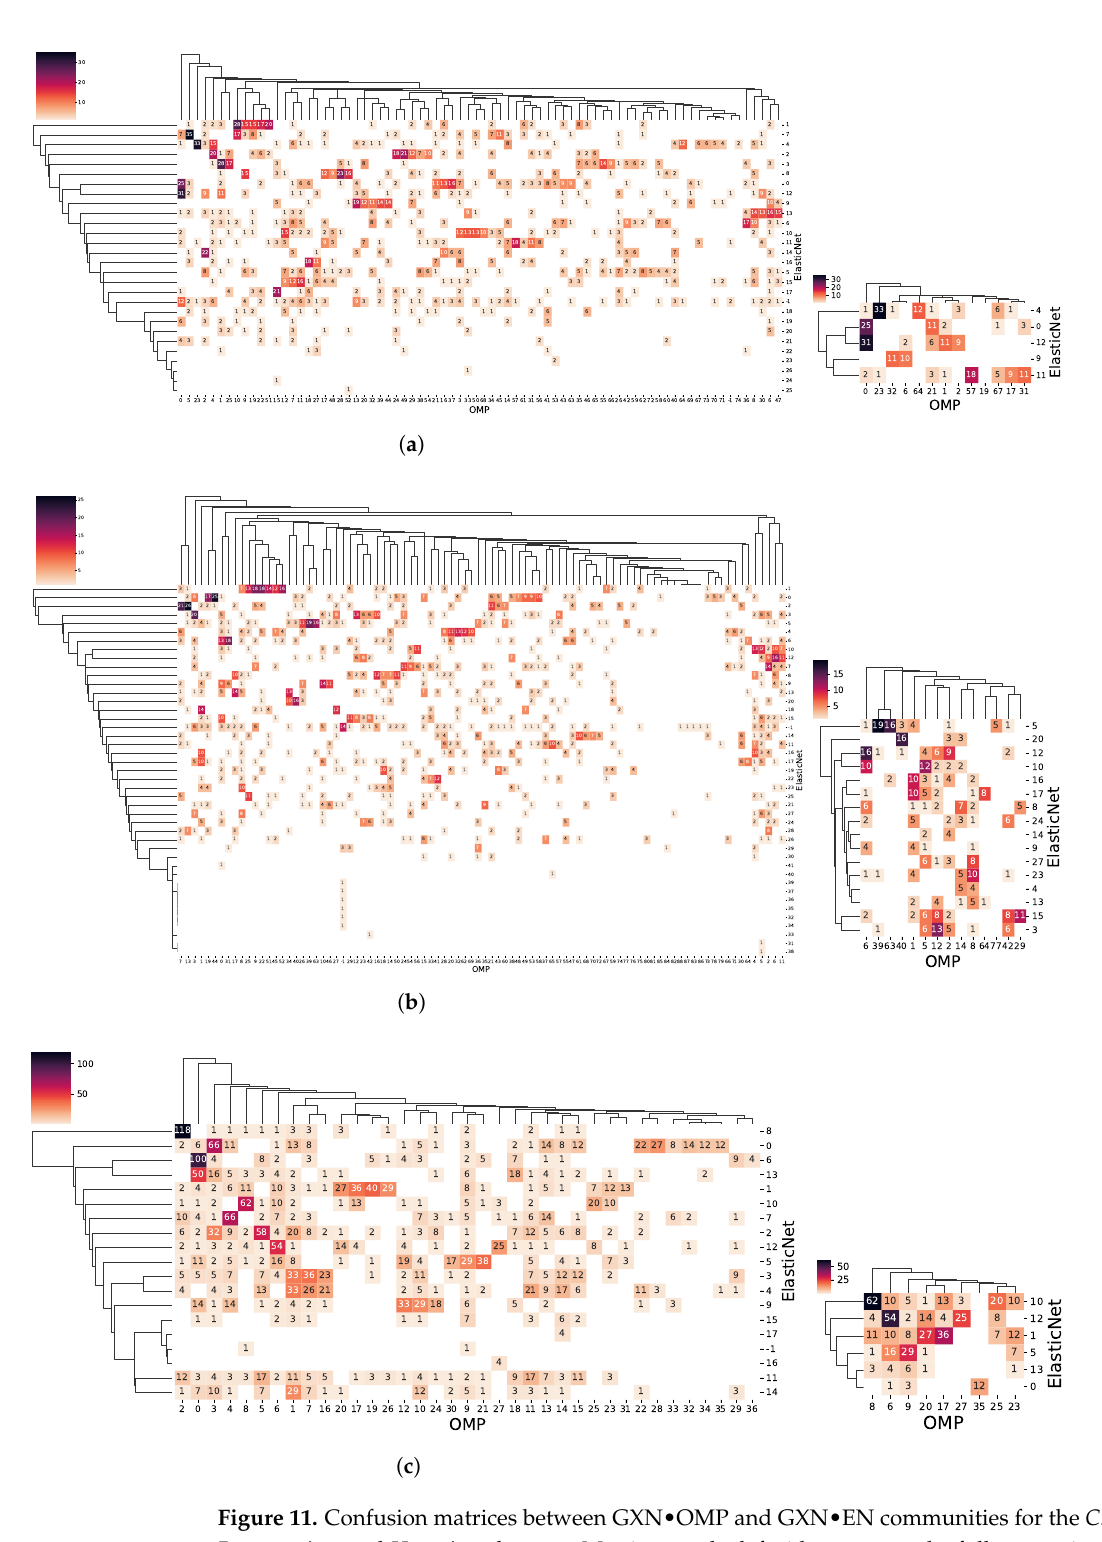
Figure 11. Confusion matrices between GXN•OMP and GXN•EN communities for the C. familiaris , R. norvegicus and H. sapiens datasets. Matrices on the left side represent the full comparison between GXN•OMP and GXN•EN communities, while matrices on the right side represent only the com- munities enriched in terms of GSEA and GO, depicted in ( a – c ); ( a ) C. familiaris ; ( b ) R. norvegicus ; ( c ) H. sapiens